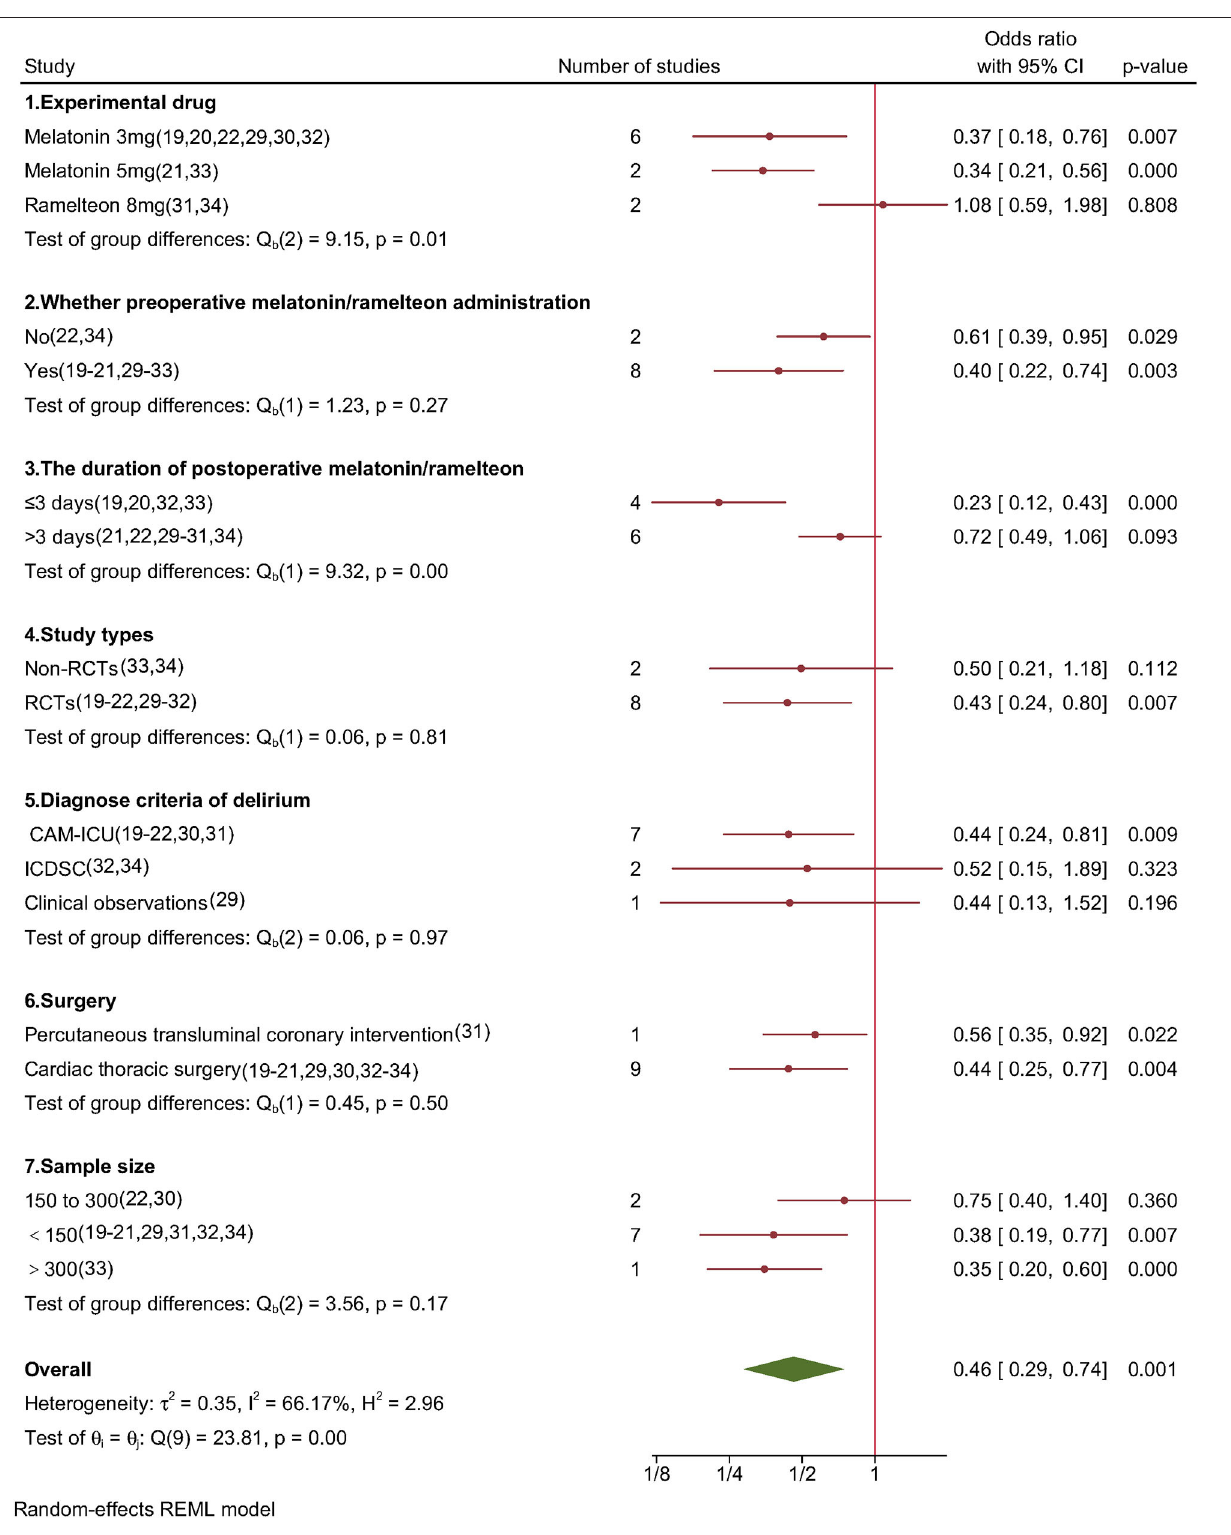
FIGURE 3 | Forest plot of subgroup analysis for POD incidence in adults who underwent cardiac surgery.